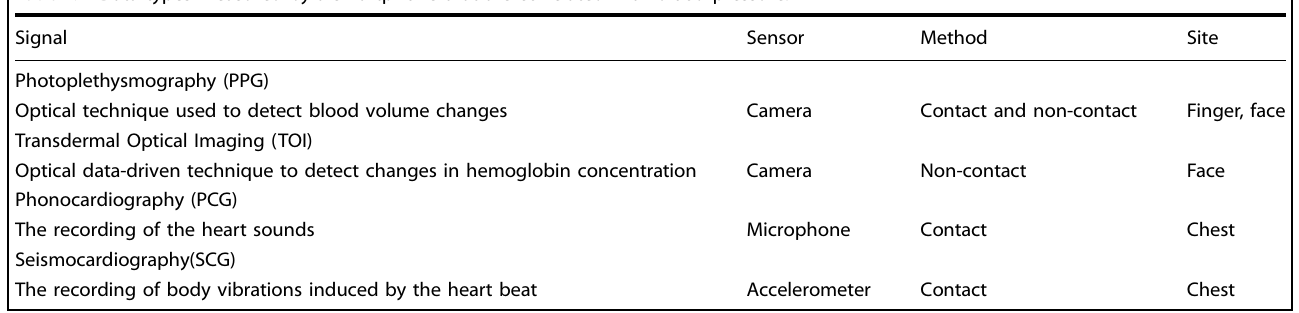
Table 2. Data types measured by a smartphone that are correlated with blood